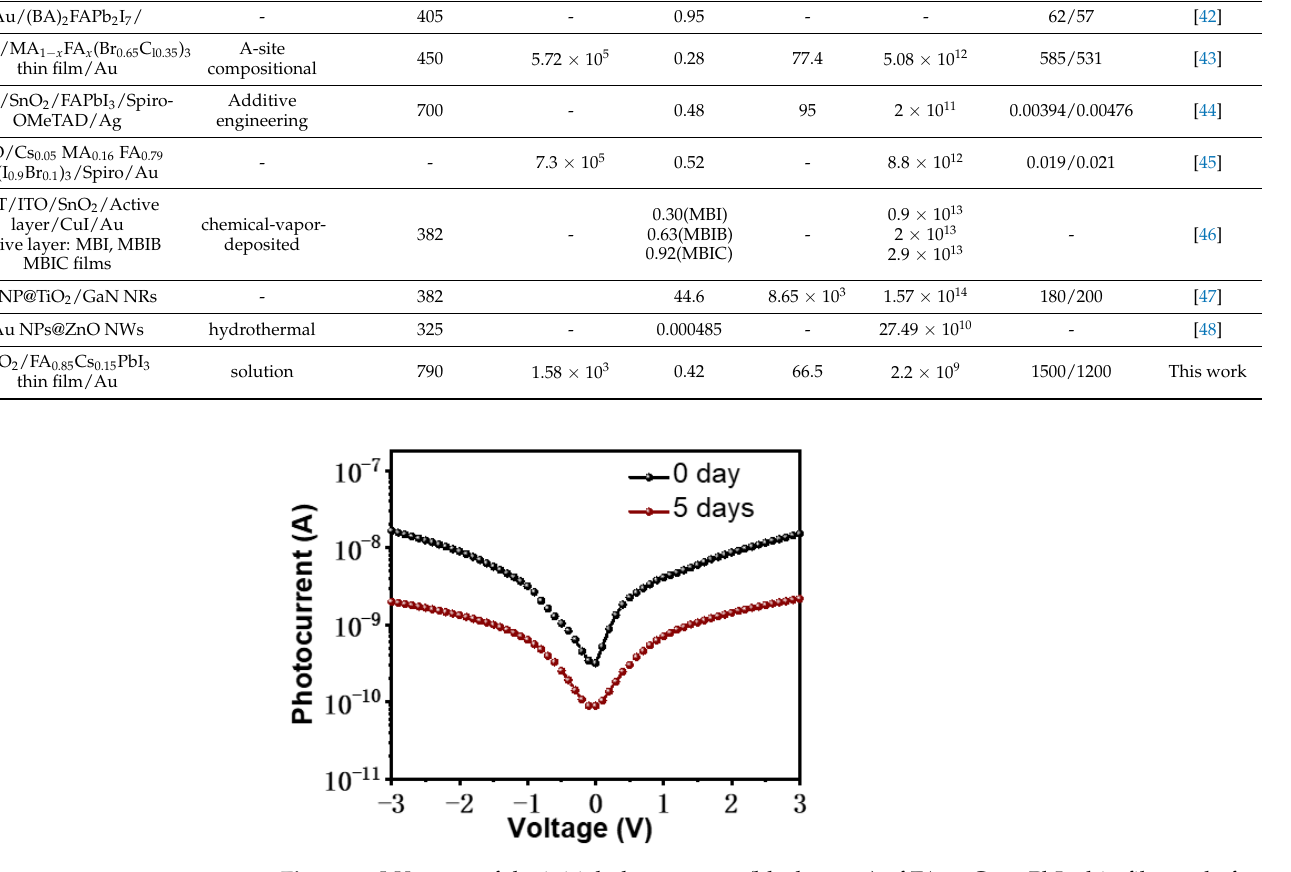
Figure 6. I-V curve of the initial photocurrent (black curve) of FA 0.85 Cs 0.15 PbI 3 thin film and after five days (red curve).